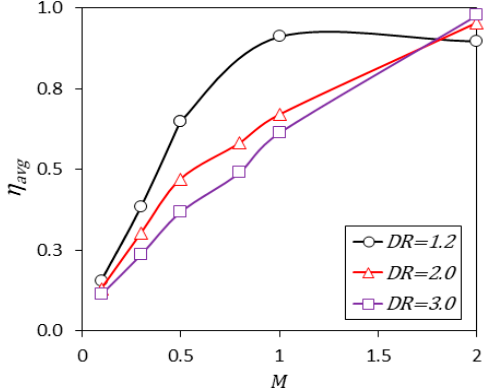
Figure 9. Variation of average AFCE with blowing ratio at three different values of 𝐷𝑅 .